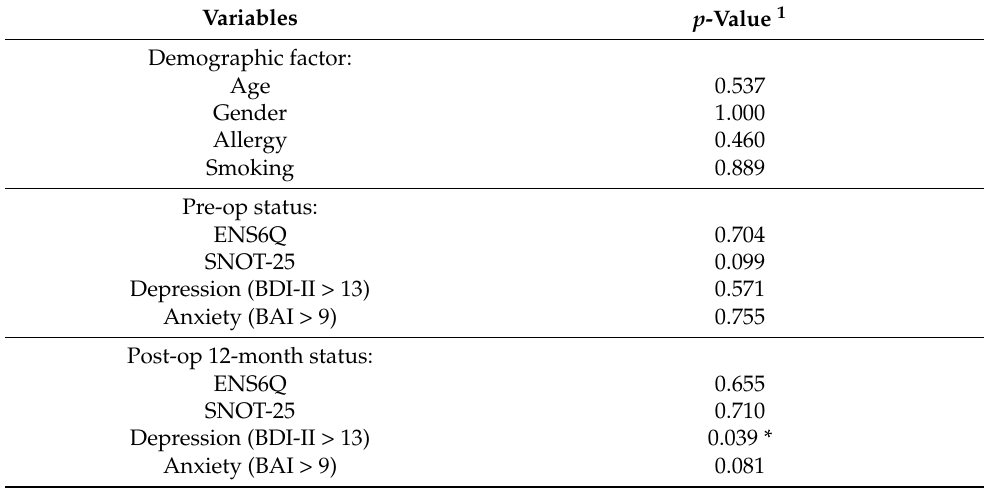
Table 2. Correlation between the preoperative hs ‐ CRP level and other parameters.